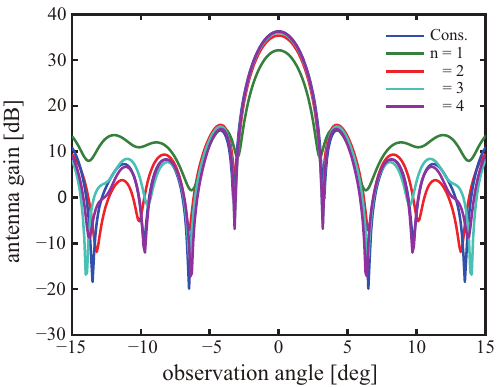
Figure 4. Simulated far-field patterns in H-plane of digitized reflectarray antennas when all required phases for high-gain antenna are quantized by the number of bits.